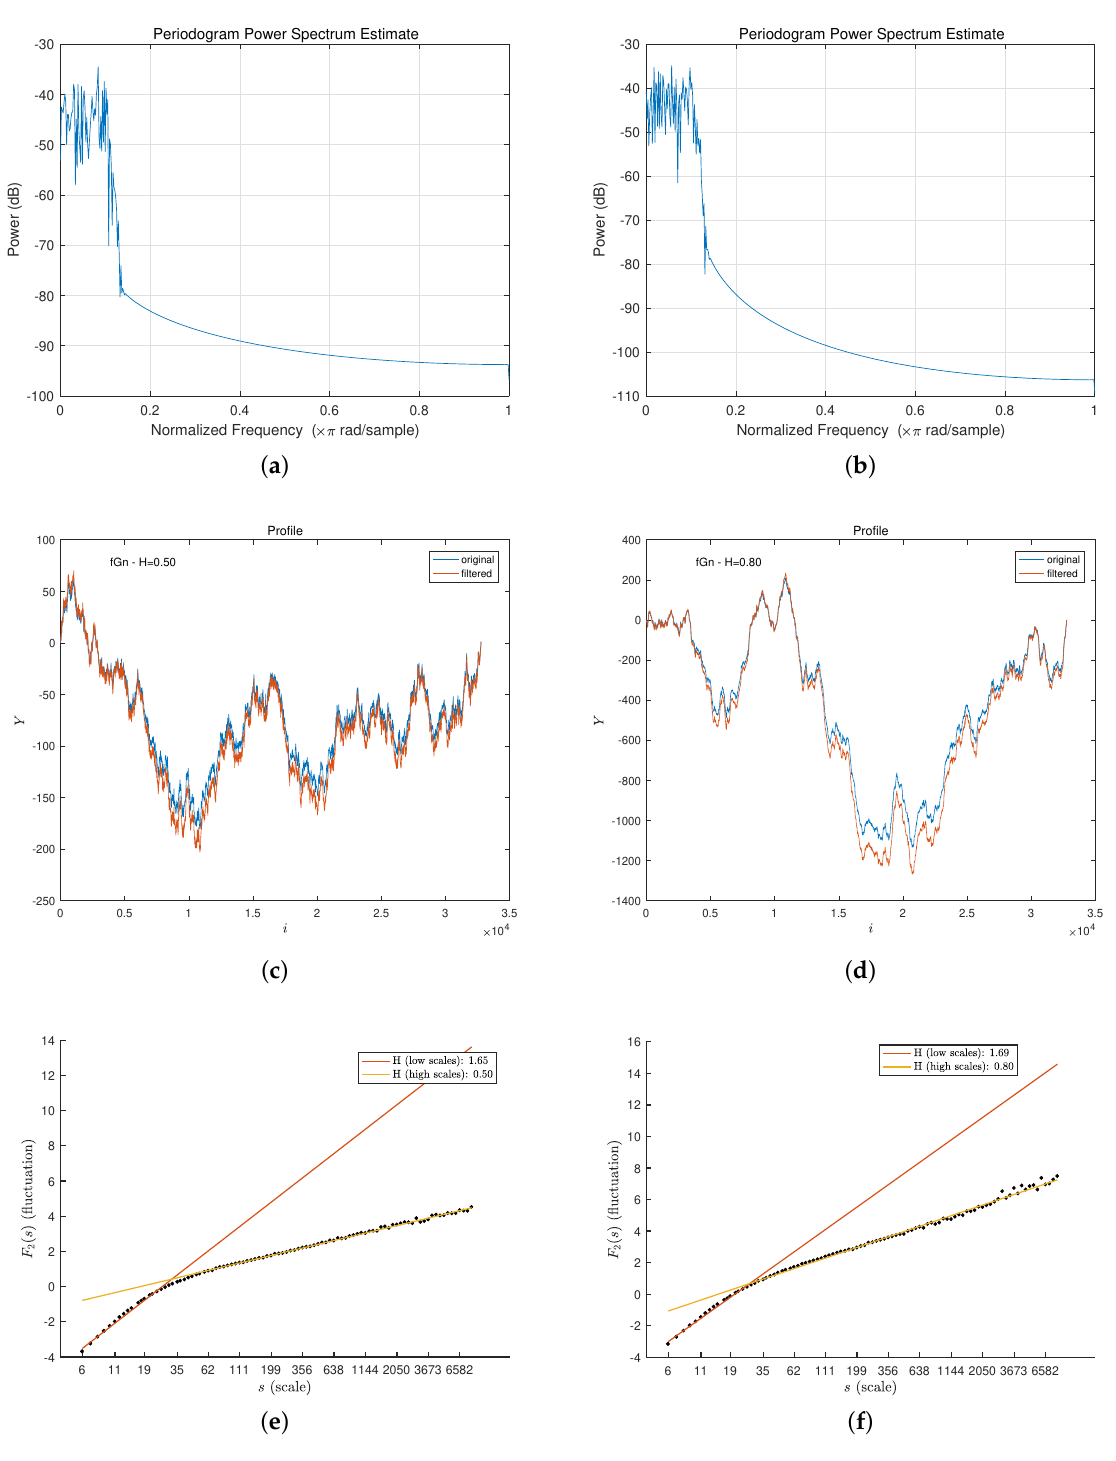
Figure 4. The behavior of the DFA1 scaling function F 2 ( s ) for two synthetic signals with Hurst exponent H = 0.5 (uncorrelated) and H = 0.8 (positively correlated) for a wide timescale range s . Panels ( a , b ) depict the power spectral density for both signals, showing how the linear-phase FIR filter suppresses the frequency components after a given cut-off frequency. Panels ( c , d ) report the profile Y ( i ) of both signals for the original and filtered version. Finally, panels ( e , f ) show the appearance of a crossover placed at low timescales due to the filtering process for both filtered signals in the DFA1 plot. However, the correct scaling behavior is asymptotically restored, i.e., it remains unchanged for higher timescale